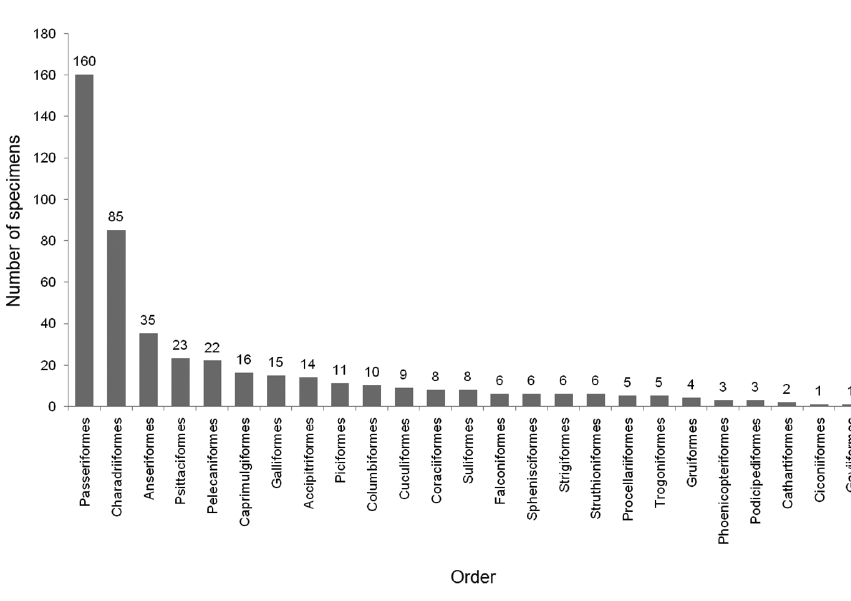
Figure 1. Total number of specimens per order represented in the exotic bird collection of the Šariš Museum in Bardejov,